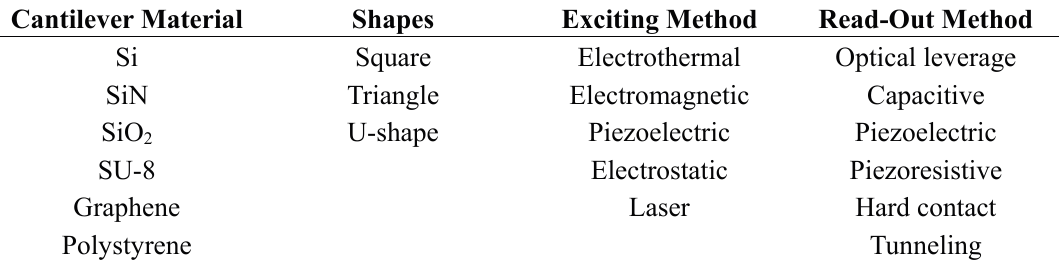
Table 1. Categorization of the resonant micro-cantilever